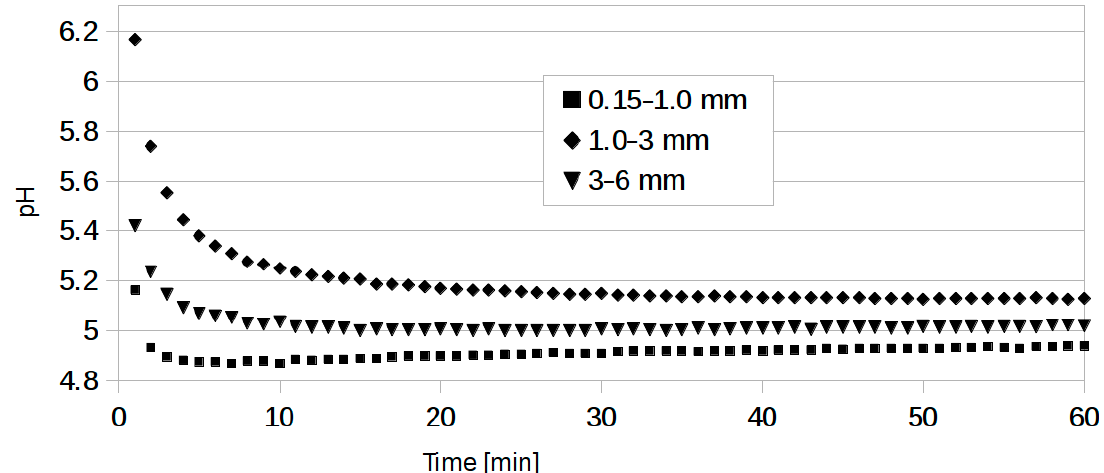
Figure 4. pH drift of pine chips in water suspension for different chip size.